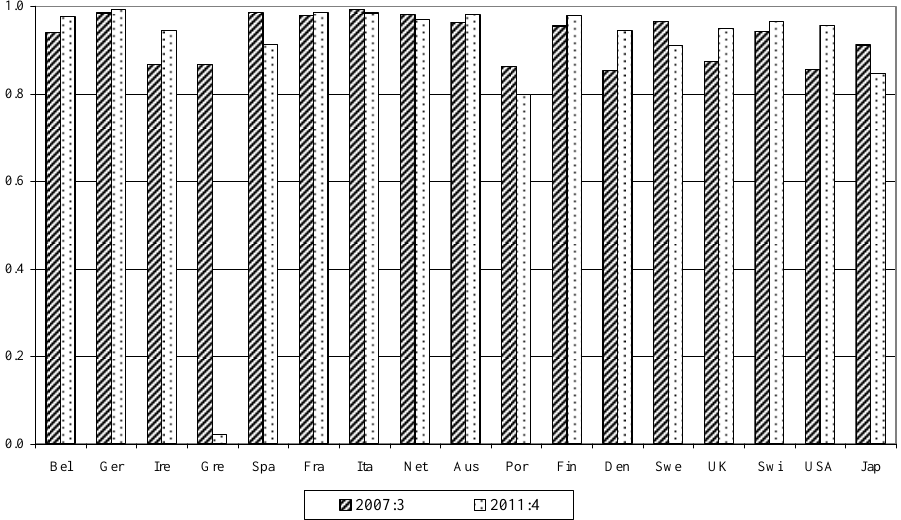
Figure 5.- Bivariate correlations between the member states and the EMU, for a 4- year rolling window: summary for relevant